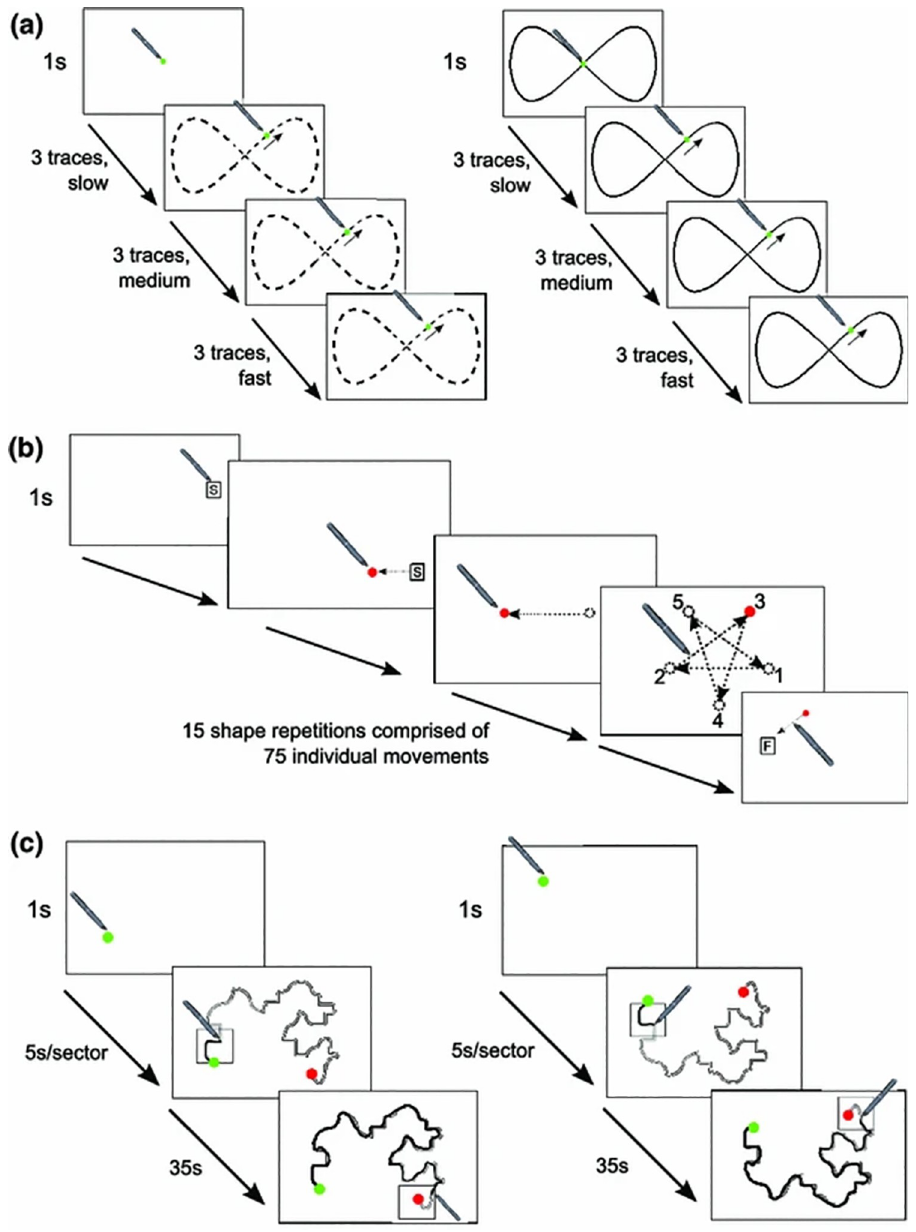
Fig 1. Illustration of the three motor control tasks: a) tracking, b) aiming and c) steering. a) Left panel shows the No Guide (NG) tracking condition, the dotted line indicates the trajectory of the moving dot. The right panel demonstrates the With Guide (WG) tracking condition, the solid line is the spatial guideline. b) Shows the aiming task. The red dot is the target, the arrows signal the movements that participants would make with the stylus between target locations and the numbers indicate the sequence in which the targets appeared. c) The left panel shows the primary path steering condition and the right panel shows the alternative path (mirror image) condition. The light grey line is the ‘ink trail’ showing the path taken. Participants follow the shape with their stylus and they are instructed to stay within the box shown, the box moves every 5 seconds. (Image adapted with permission from Flatters et al [47]). Note, only the aiming task (panel b) is completed during Experiment 1, whereas all three tasks (panel a-c) are completed in Experiment 2 and, therefore, are included here for future reference.